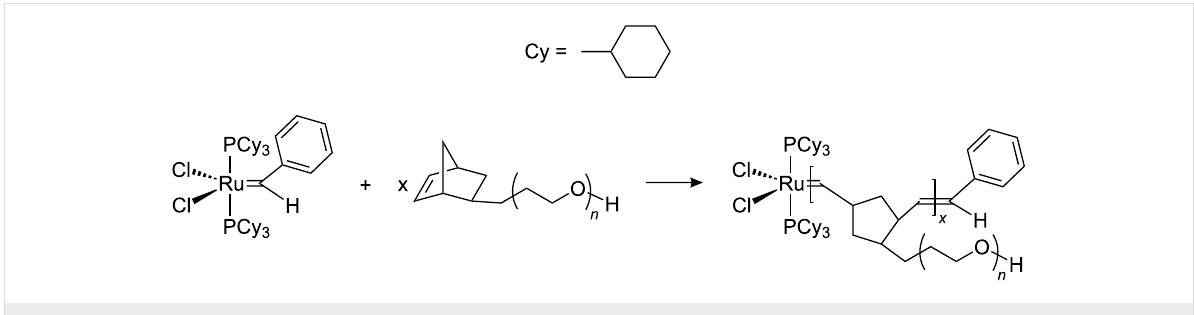
Scheme 1: Synthesis of the macroinitiator for ROMP in direct miniemulsion [71].